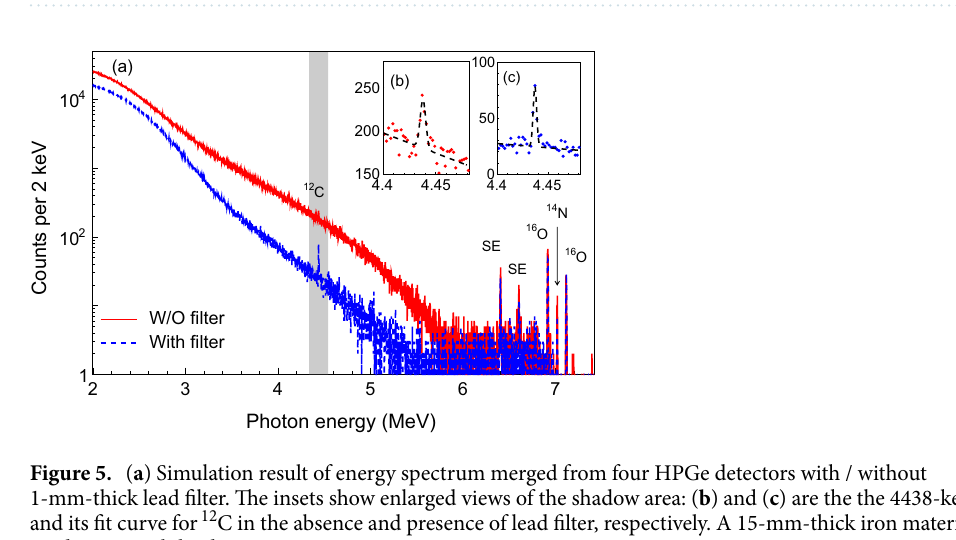
Figure 4. Element ratios of oxygen to carbon ( a ) and nitrogen to carbon ( b ). Coca., Meth., Keta., Hero. and Caff. are abbreviations for the drugs Cocaine, Methamphetamine, Ketamine, Heroin and Caffeine, respectively.